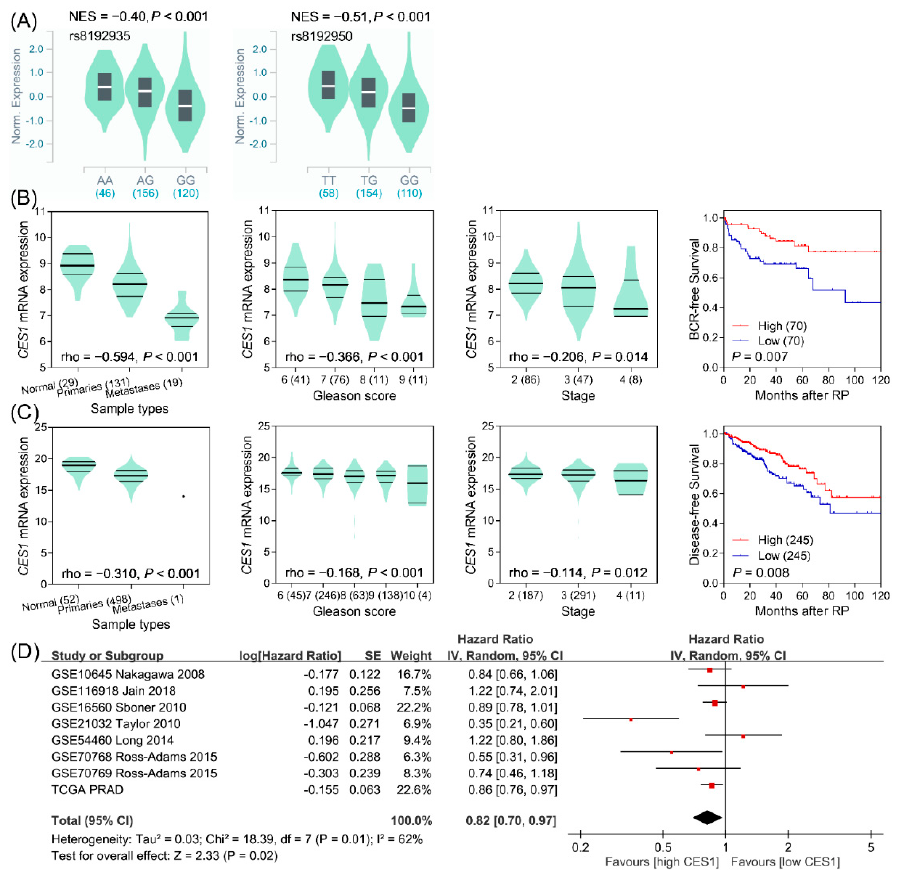
Figure 2. Association of CES1 polymorphisms with prostate cancer progression. ( A ) The correlation of rs8192935 (left) and rs8192950 (right) genotypes with CES1 mRNA expression levels in testis tissues from the Genotype–Tissue Expression database. NES, normalized effect size. Lower expression of CES1 correlates with prostate cancer, a higher Gleason score and stage, and poorer patient prognosis in the Taylor cohort ( B ), as well as in The Cancer Genome Atlas (TCGA) cohort ( C ). BCR, biochemical recurrence. RP, radical prostatectomy. rho, Spearman's rank correlation coefficient. ( D ) Meta-analysis of eight studies evaluating the hazard ratio of high compared with low levels of CES1 mRNA expression for prostate cancer prognosis. SE, standard error. IV, inverse variance.